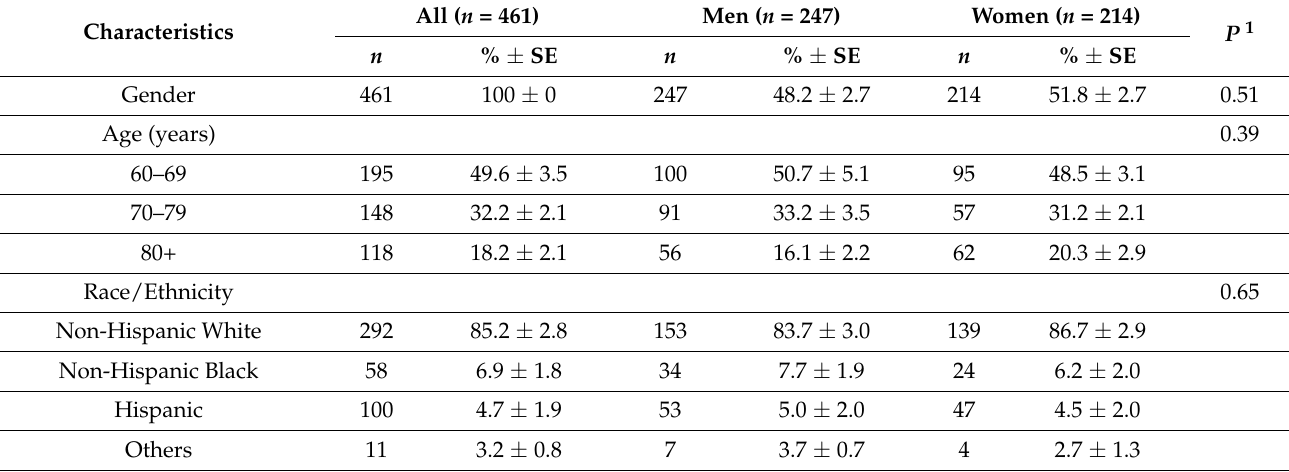
Table 1. Demographic, socioeconomic, and other characteristics of participants by gender among US adults aged ≥ 60 years, NHANES